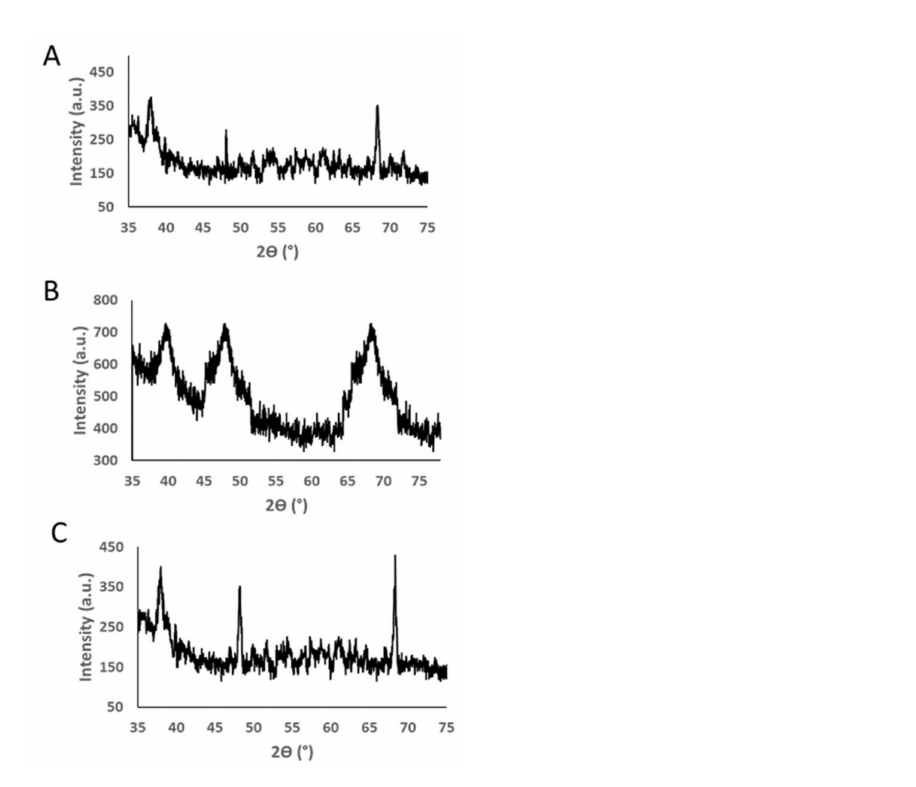
Figure 3. X-ray diffraction (XRD) profiles of ( A ) Pt NPs, ( B ) Pd NPs, and ( C ) Pt–Pd NPs greenly synthesized by P. harmala seed alkaloid fraction.